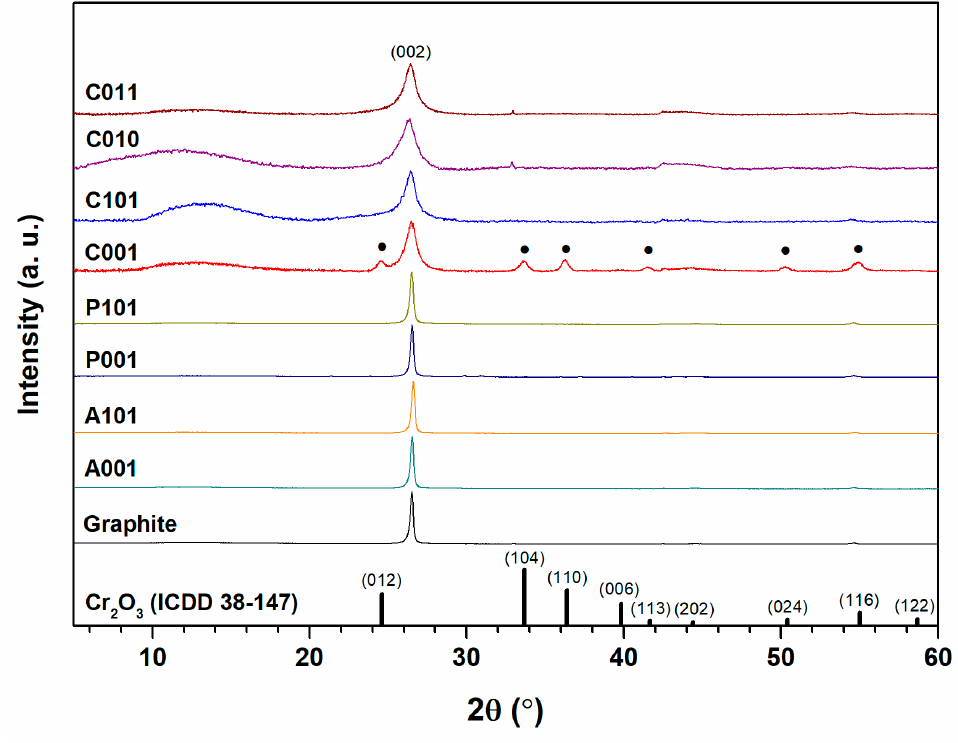
Figure 10. XRD patterns of GBS products, graphite, and Cr 2 O 3 (ICDD 38-147; marked with ● ). Table 3. XRD peak positions, interplanar spacing d 002 and crystallite size of the annealed and water- treated GBS products.